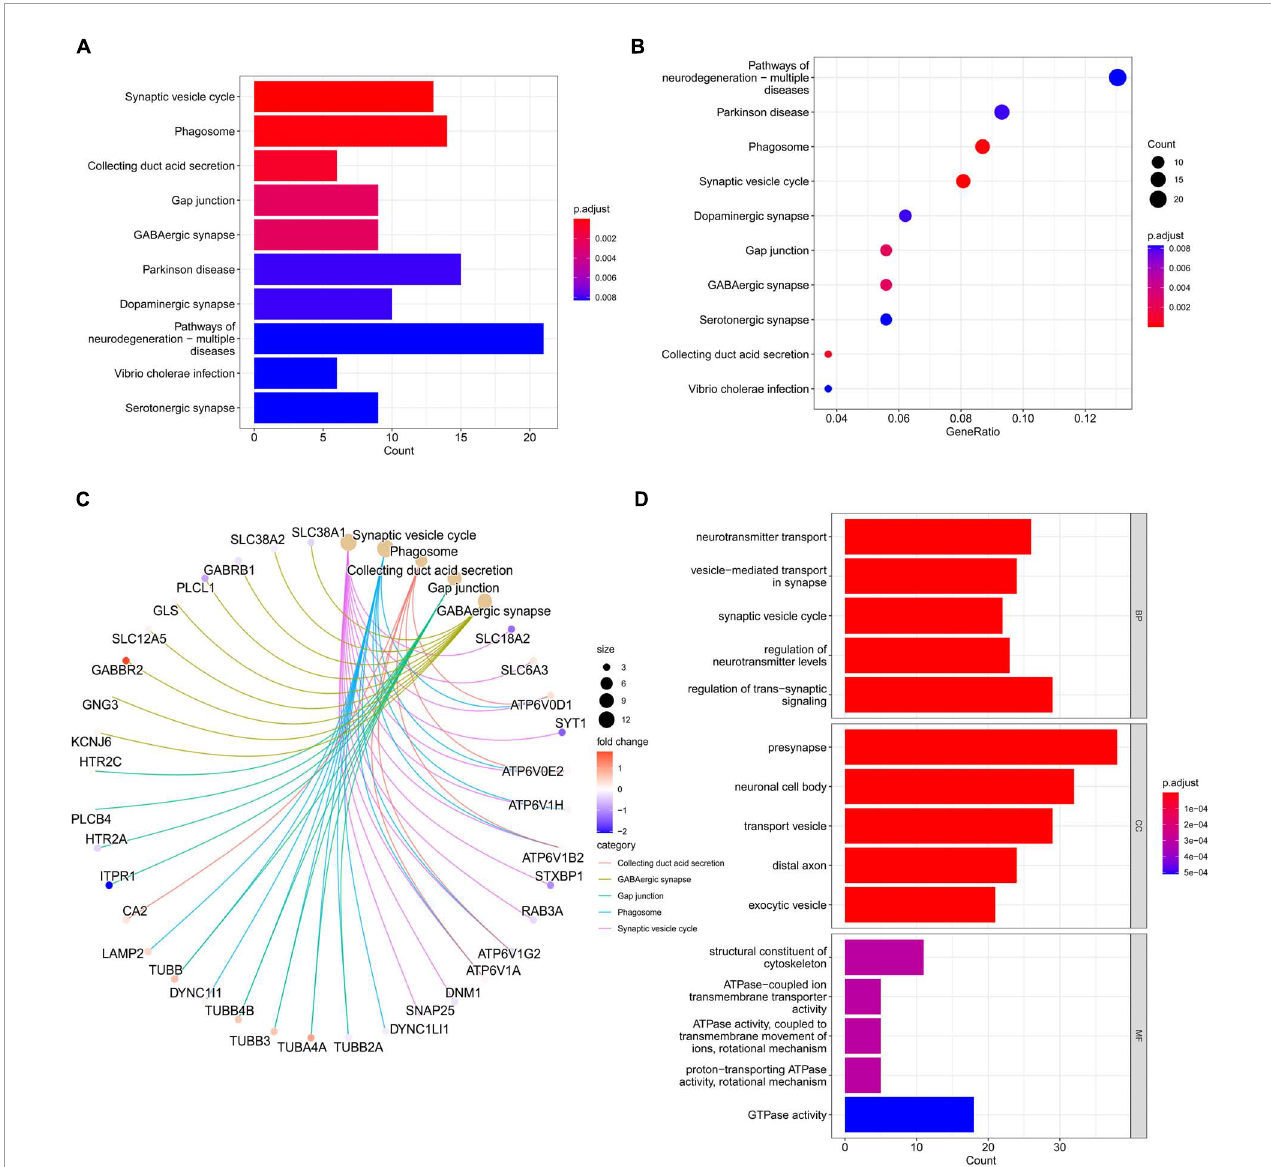
FIGURE3 Gene ontology and KEGG pathway enrichment analyses of DEGs. (A) Barplot of KEGG analysis based on the obtained 263 genes. (B) The bubble diagrams show the top ten significantly enriched terms in KEGG analysis. The X -axis is the GeneRatio (gene count/gene size) of the term, and the Y -axis denotes the name of the term. The darker the color is, the smaller the adjusted p -value is. (C) Subnetwork showing the top five KEGG pathways and related genes. (D) The top 5 terms for BP, CC, and MF with p < 0.05 are shown. DEGs, differentially expressed genes; KEGG, Kyoto Encyclopedia of Genes and Genomes; GO, gene ontology; BP, biological processes; CC, cell component; MF, molecular